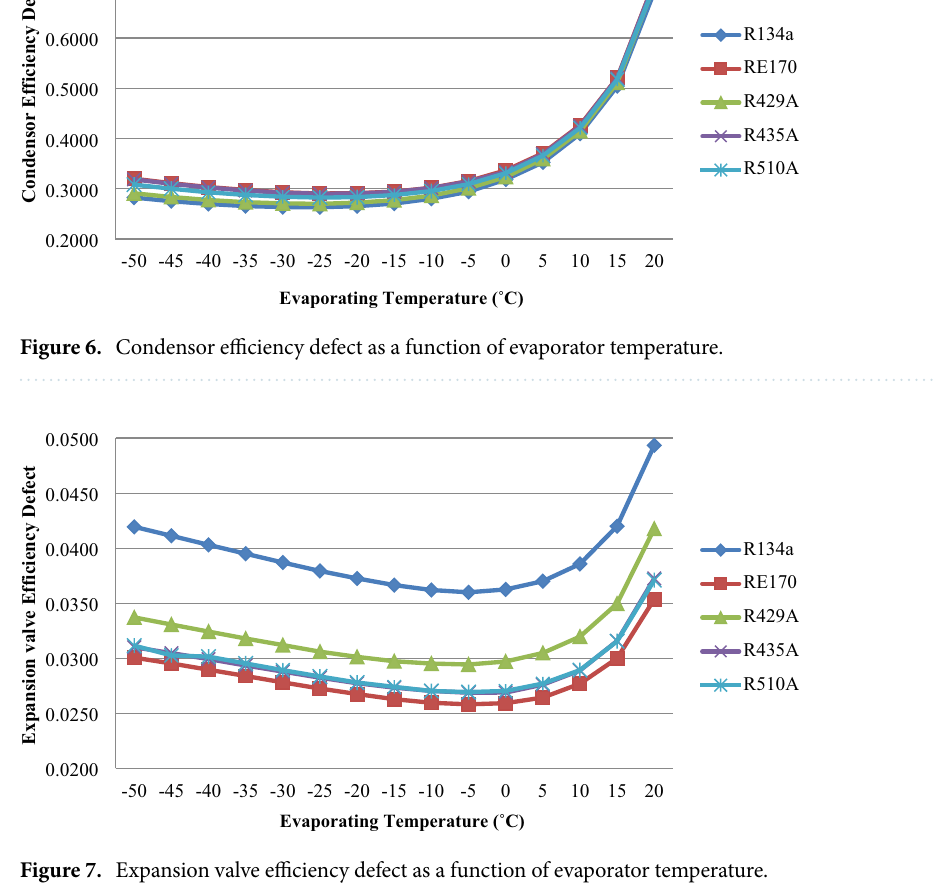
Figure 7. Expansion valve efficiency defect as a function of evaporator